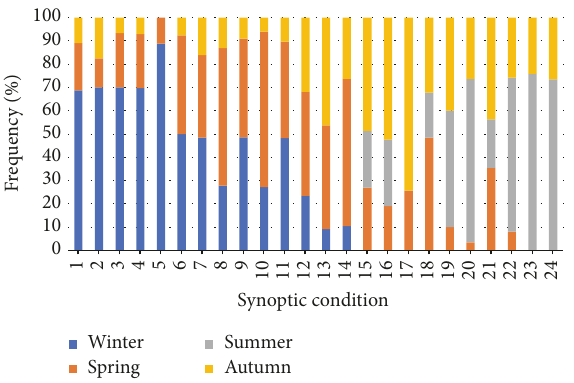
Figure 9: Frequency of appearance of classes in seasons for the 2003–2005 period.